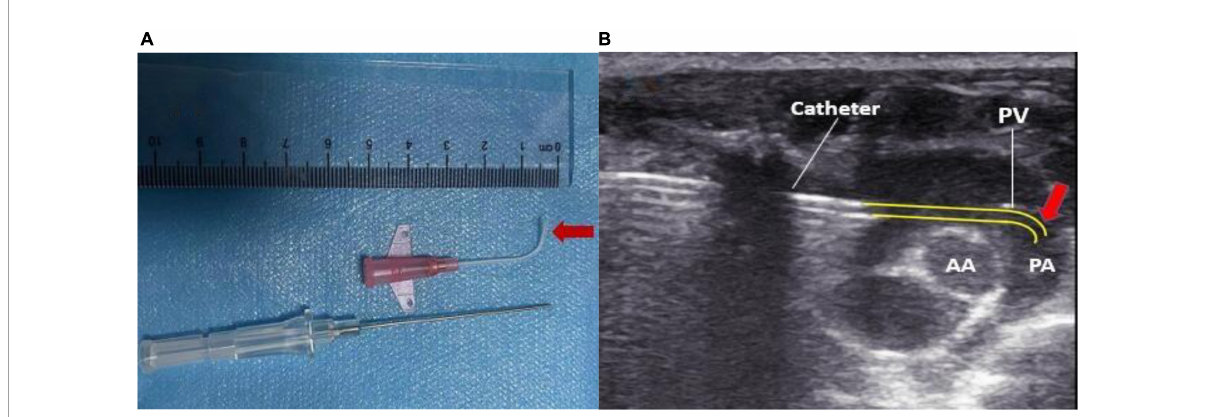
FIGURE1 (A) The cannula tip was maintained at a bend of 90 ◦ by 1 cm using heat shaping. (B) Pressure measurement over the pulmonary valve reached by the reshaped catheter. PA, pulmonary artery; AA, aorta; PV, pulmonary valve.